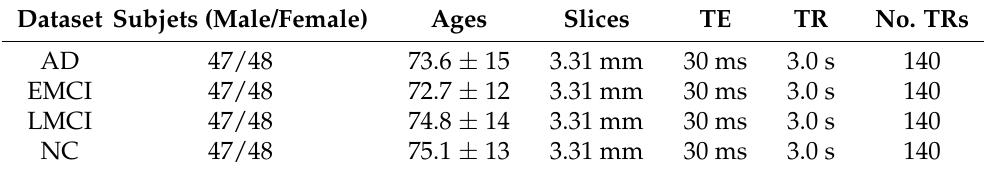
Table 1. Details of ADNI data